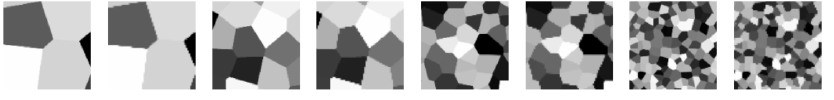
Figure 2. Pairs of images featuring original resolution ( left ) and reduced resolution ( right ), for all the considered values of h .